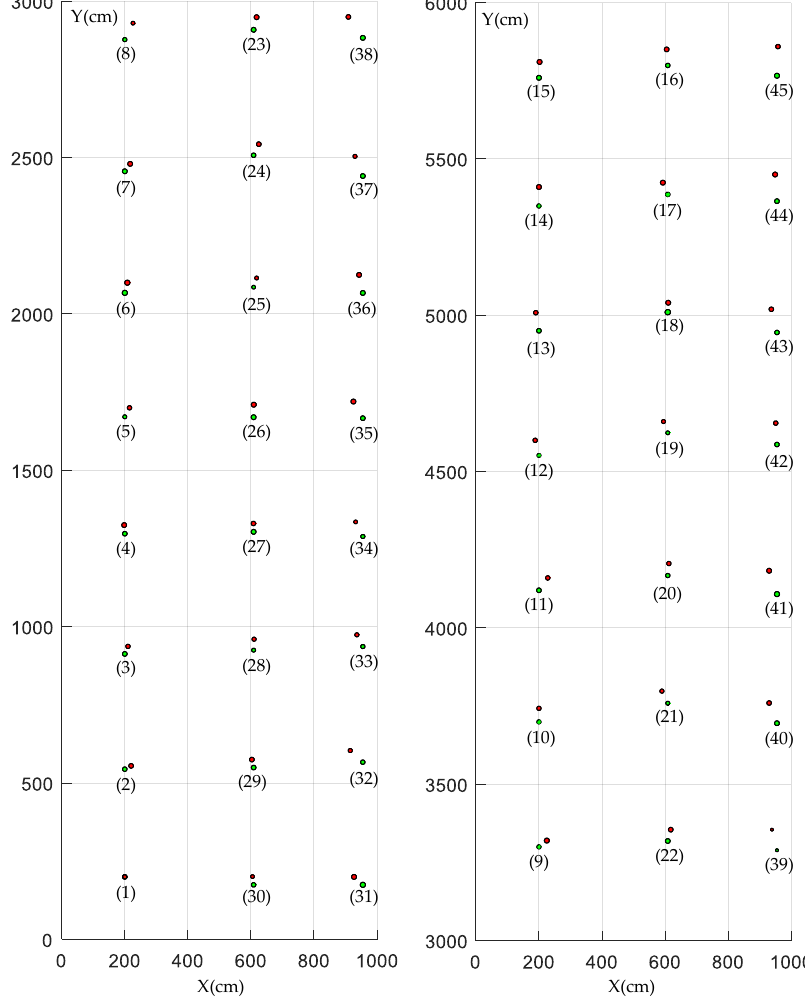
Figure 19. Comparison of forest maps.